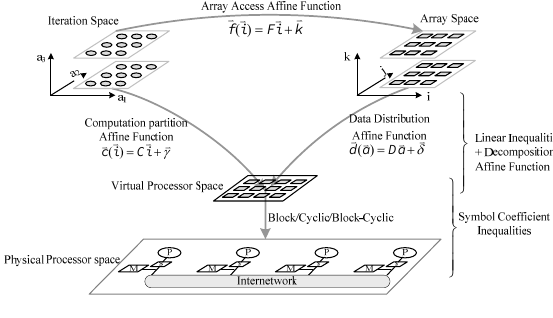
Figure 4. Two level mapping model